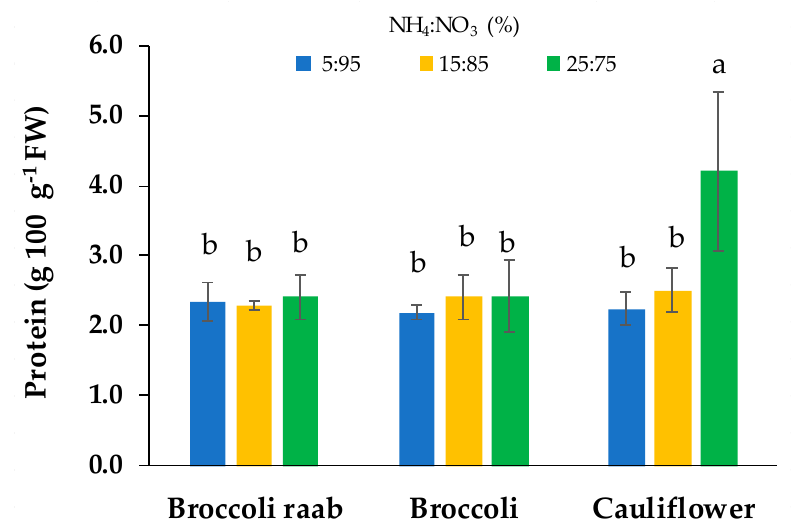
Figure 6. Protein content of three genotypes of microgreens grown by using a NS with three di ff erent NH 4 + :NO 3 − (%) molar ratios: 5:95, 15:85 and 25:75. Di ff erent letters indicate that mean values are significantly di ff erent, according to the SNK test ( p = 0.05). Vertical bars represent ± standard deviation of mean values.